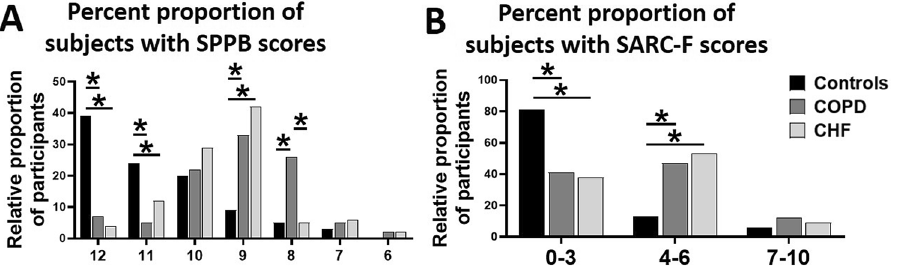
Figure 1. Relative proportions of the participants with different SPPB ( A ) and SARC-F ( B ) scores in the healthy controls (N = 87) and patients with COPD (N = 86) and CHF (N = 81). Values are expressed in percentages, * p <